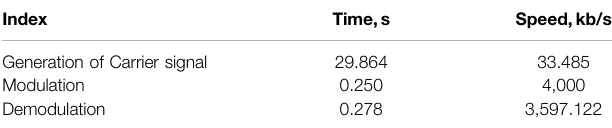
TABLE 7 | Results of time and speed of the